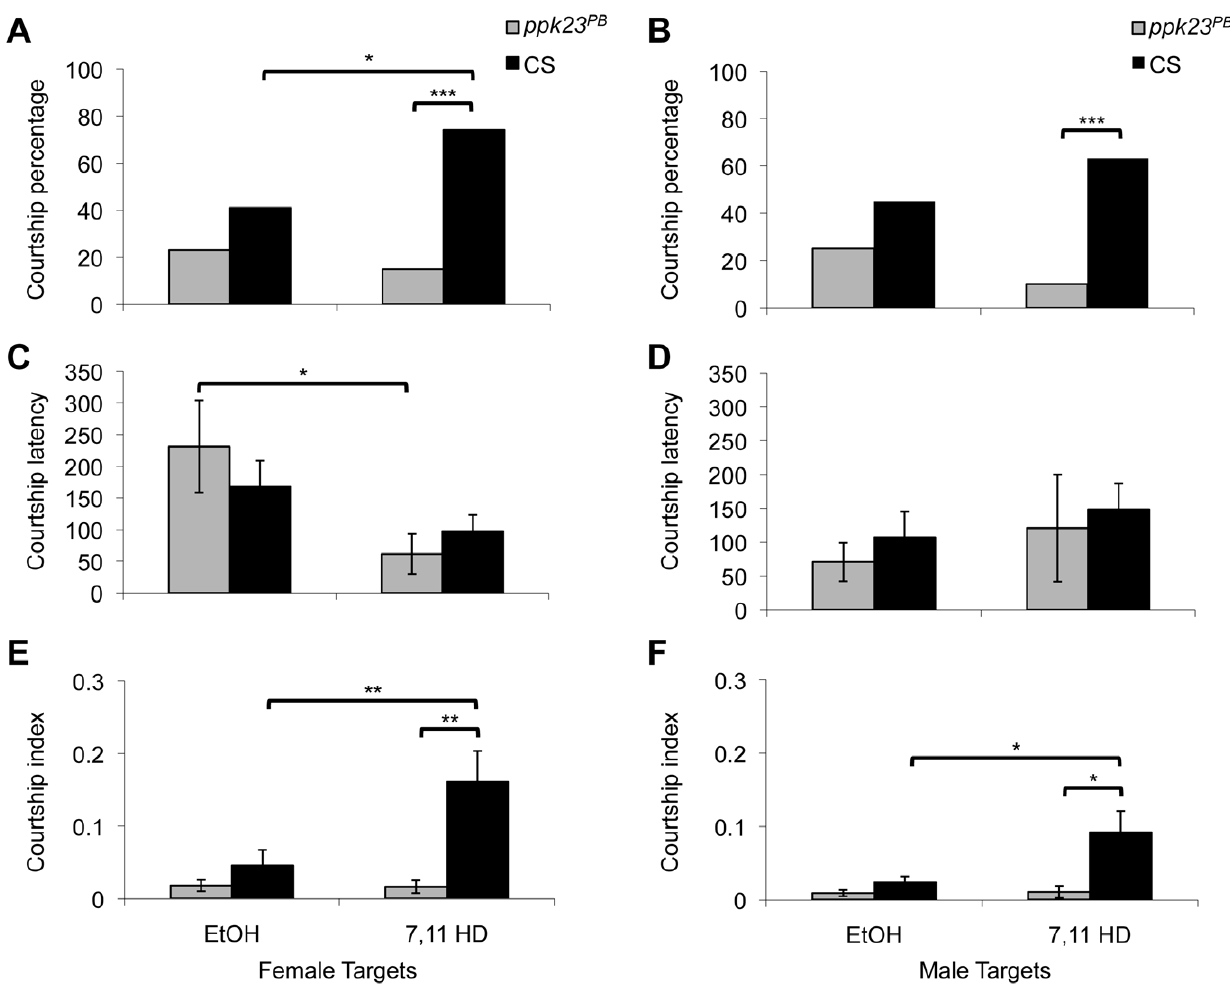
Figure 7. The behavioral response to the aphrodisiac pheromone 7,11-HD is reduced in ppk23 PB flies. (A–B) Larger percent of wild type CS flies exhibited courtship behavior in response to male or female targets laced with 125 ng 7,11-HD ( Chi-squared test ; only significant contrasts are shown; *, p , 0.05 ; **, p , 0,01 ; ***, p , 0.001, n=20–30 for each genotype per treatment). (C–D) Courtship latency was not affected by the ppk23 mutation in flies that did court pheromone-laced dummies. (E–F) Significant effects of ppk23 mutation on courtship index were observed in males that courted pheromone-laced dummies ( Two samples t-test or two samples wilcoxon test , *, p , 0.05 ; **, p , 0,01 ; ***, p , 0.001, n=20–30 for each genotype per